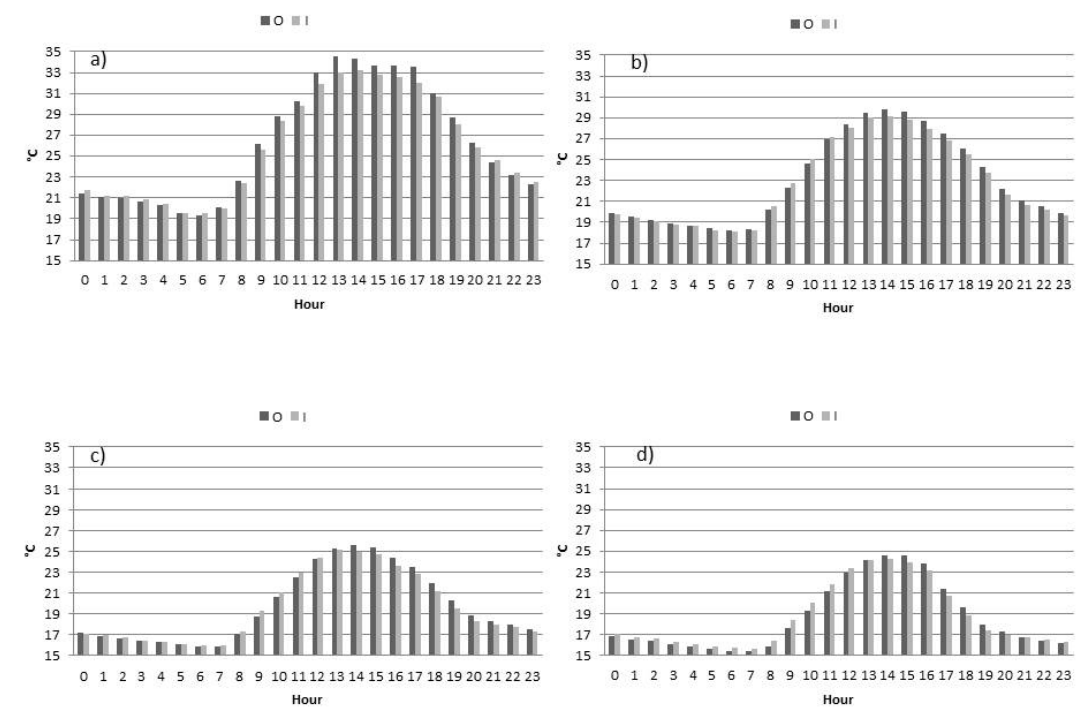
Figure 1. Hourly temperature (°C) outside (O) and inside (I) the bag in ( a ) July, ( b ) August, ( c ) September, and ( d ) October. Table 1. Day and night temperatures (°C) inside and outside the bag. Month External